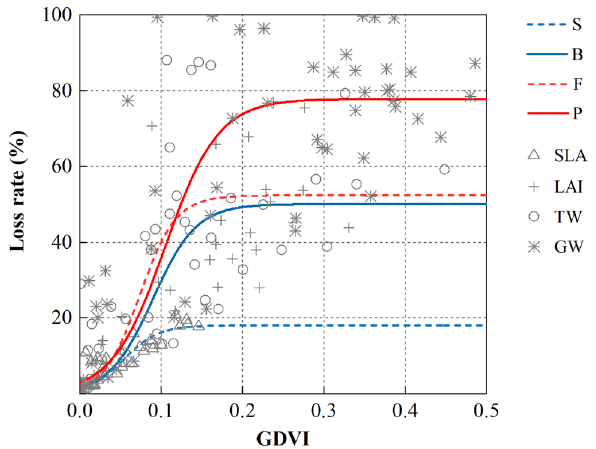
Fig. 6 Correlation curves of the growth-stage-based drought vulner- ability index (GDVI) and growth loss in individual soybean growth stages in the Huaibei Plain study area in Anhui Province, China. Note: SLA = Specific leaf area; LAI = Leaf area index, TW = Tops weight; GW = Grain weight. S = Seedling stage; B = Branching stage; F = Flowering & pod-setting stage; P = Pod-filling stage